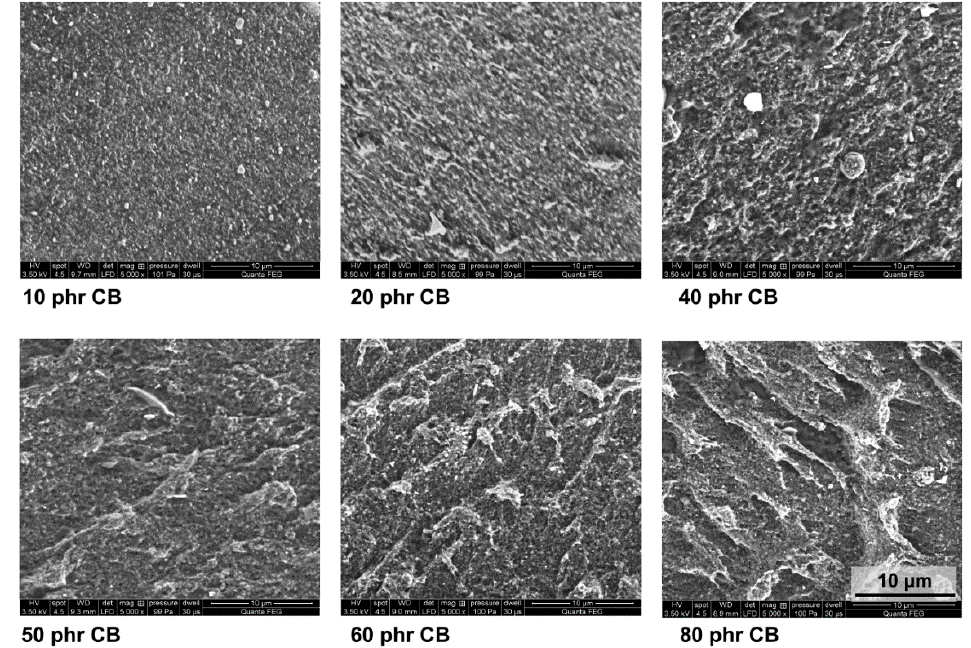
Figure 3. SEM images of the SBS rubber with different carbon black (CB) content. All the images with × the same magnification (5000×). the same magnification (5000